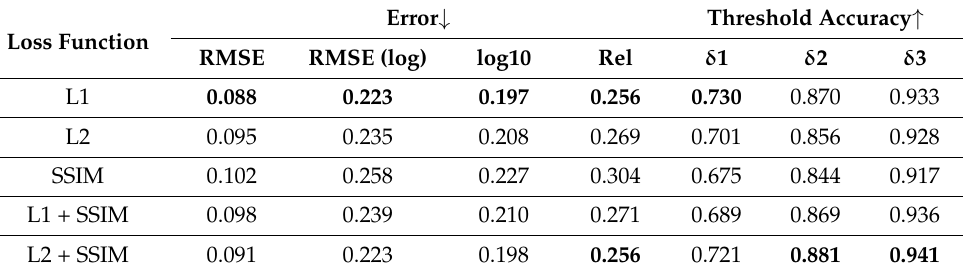
Table 3. Comparison of model depth prediction results under different loss functions.